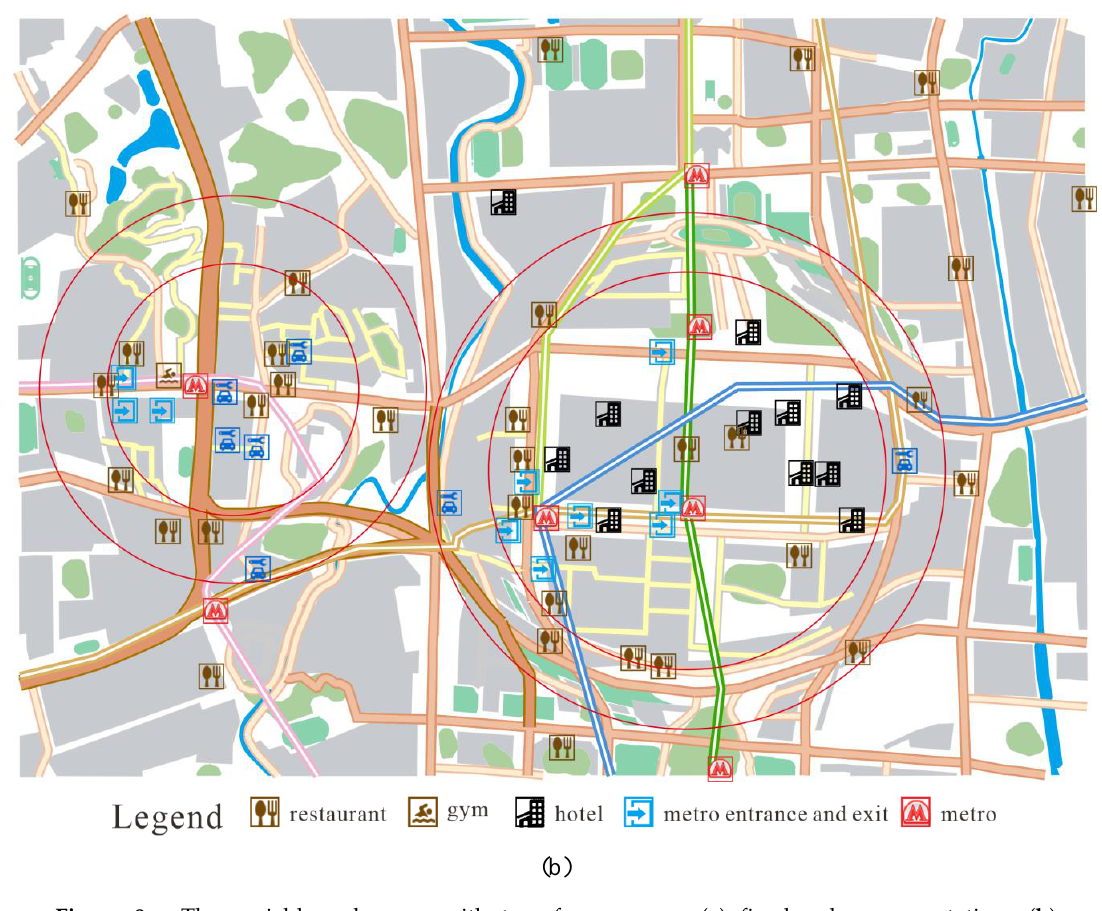
Figure 9. The variable-scale map with two focus areas: ( a ) fixed-scale representation; ( b ) variable-scale representation.